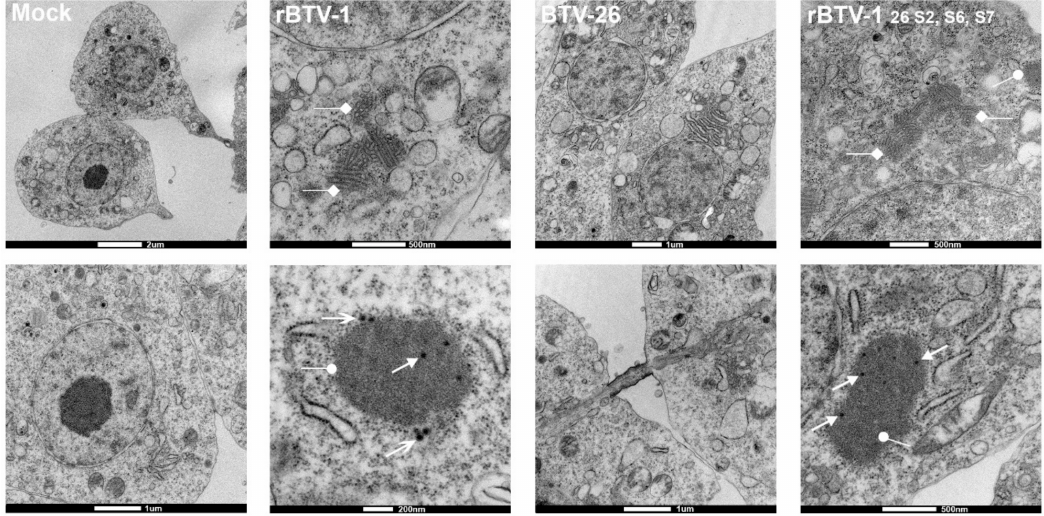
Figure 6. Transmission electron microscopy (TEM) of Culicoides cells infected with rBTV-1, BTV-26 or rBTV-1 26 S2,S6,S7 . KC cells on coverslips were either mock infected or infected at a MOI of 5 and incubated at +27 ◦ C with rBTV-1, BTV-26, or rBTV-1 26 S2,S6,S7 . At 2 dpi, cells were fixed with phosphate buffered 2% glutaraldehyde. Cells were visualised by TEM (FEI Tecnai 12 TEM with a TVIPS F214 digital camera). Open arrows show whole virus particles (only in rBTV-1), arrows show viral core particles, ovals show viral inclusion bodies (VIBs) made of NS2, and diamonds show viral microtubules made of